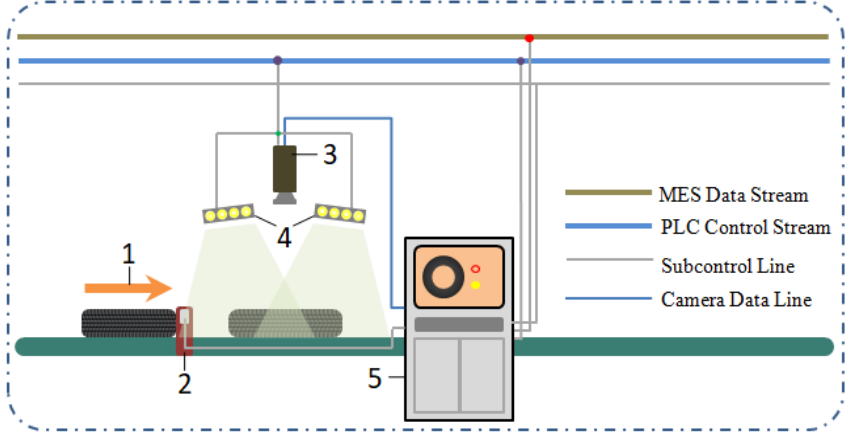
Figure 1. Online image collection system of the tire marking point: 1 — Direction of the tire movement, 2 — Photoelectric switch, 3 — Industrial camera, 4 — Light Emitting Diode (LED) light, and 5 — Host computer.